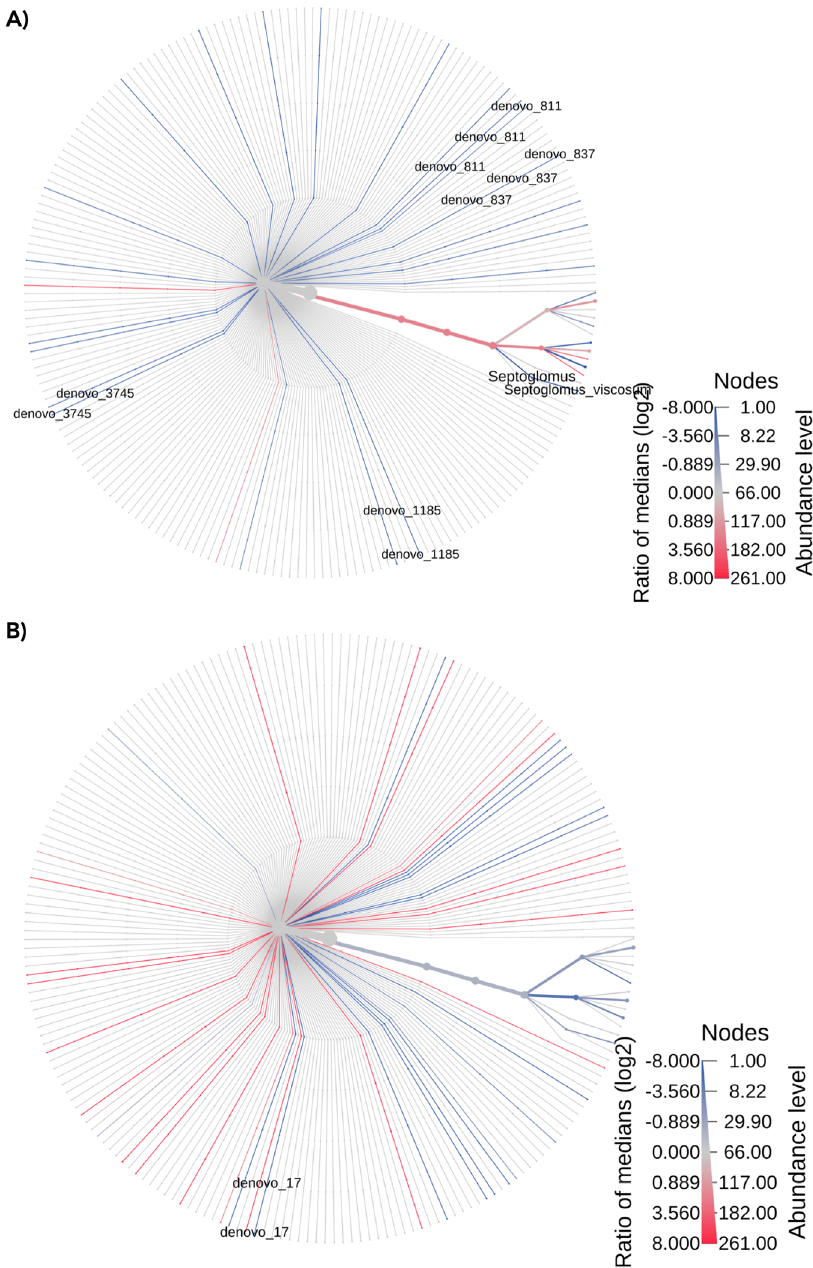
Figure 4. Heat tree of factor Time. Heat Trees report the effect of the sampling time on hierarchical structure of taxonomic classifications (median abundance, non-parameter Wilcoxon Rank Sum test). ( A ) Bs1 vs Bs2; ( B ) Rs1 vs Rs2. Heat tree analysis was performed using R metacoder package of MicrobiomeAnalyst, a free available on-line software